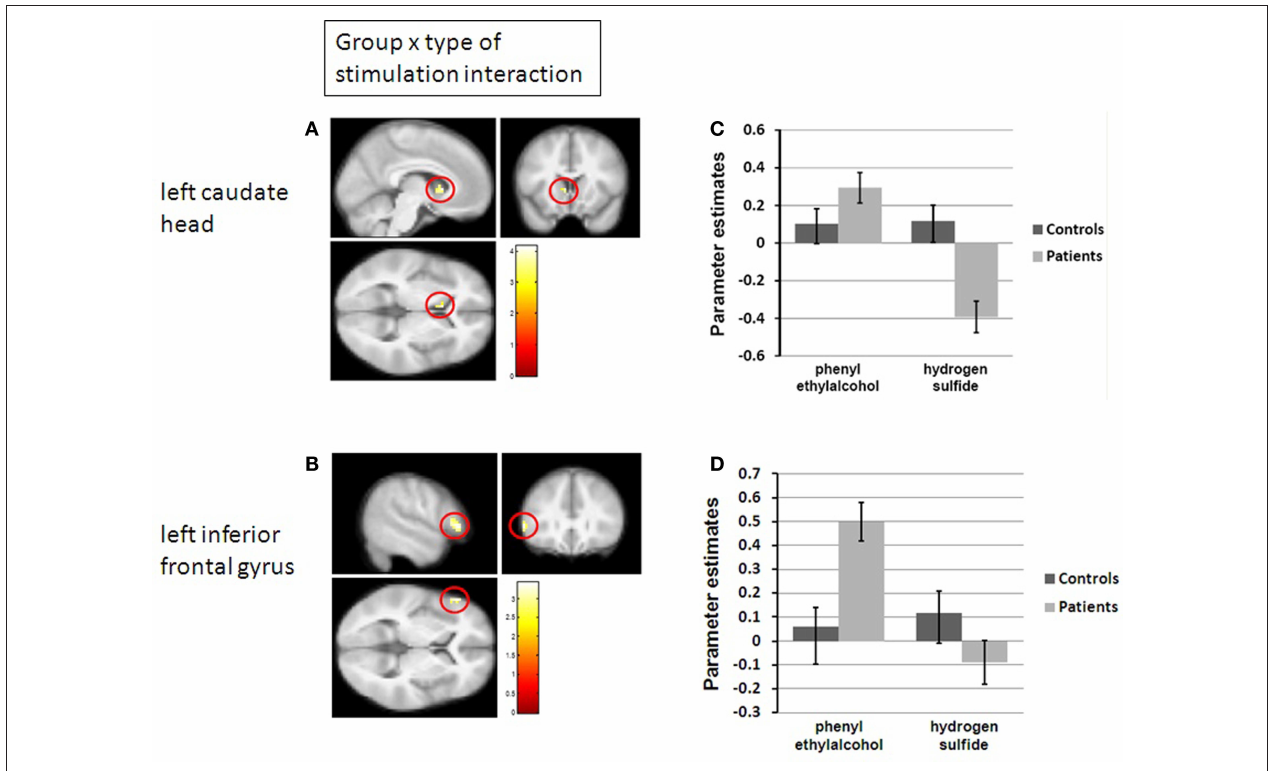
FIgure 2 | Differential brain activation in controls and patients. (A) Group × type of stimulation interaction in the left caudate head ( P < 0.05, FWE-corrected for search volume left caudate). MNI coordinates of peak voxel: x = − 6, y = 15, z = 3. (B) Group × type of stimulation interaction in the left inferior